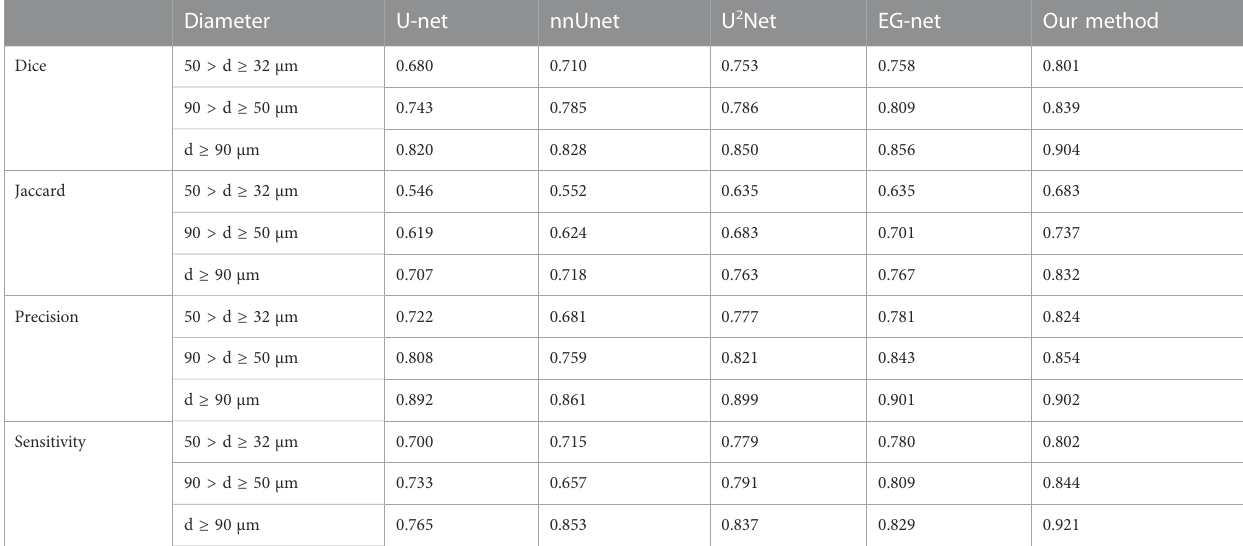
TABLE 1 Comparison between the proposed segmentation method and other single neural